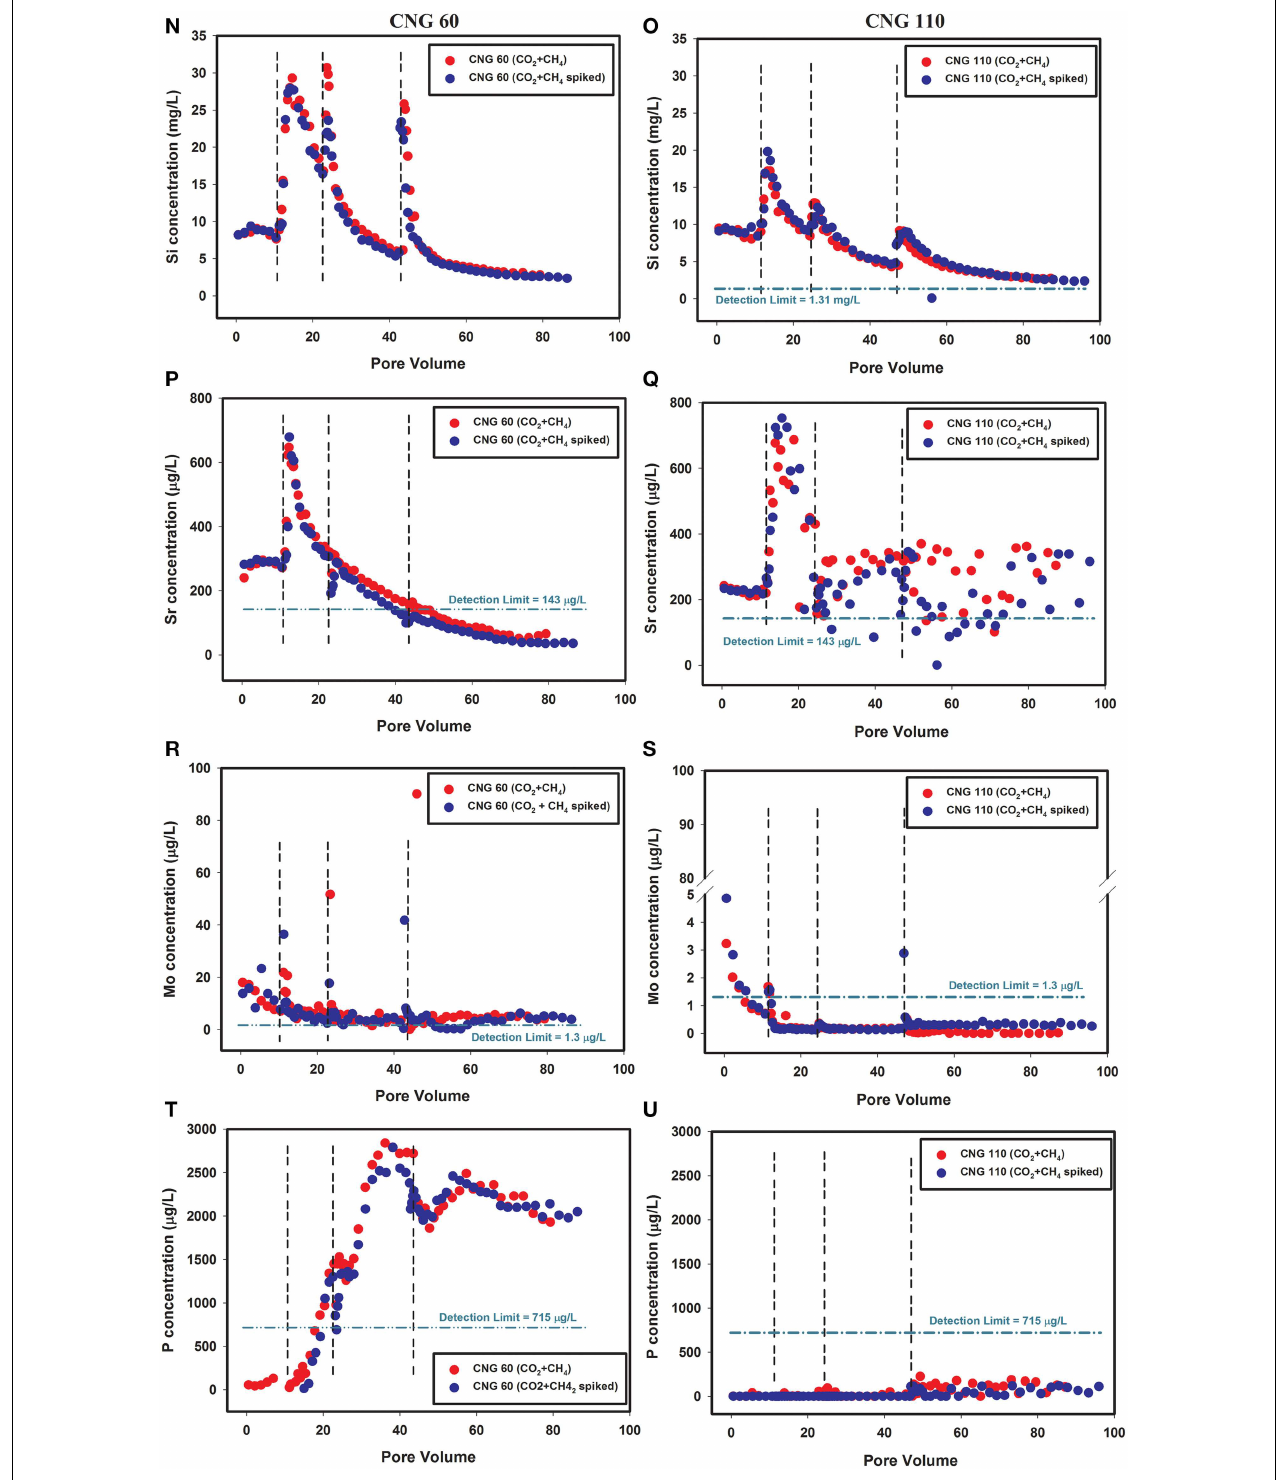
FIGURE 3 | Continued: Si (N,O) , Sr (P,Q) , Mo (R,S) , and P (T,U) .